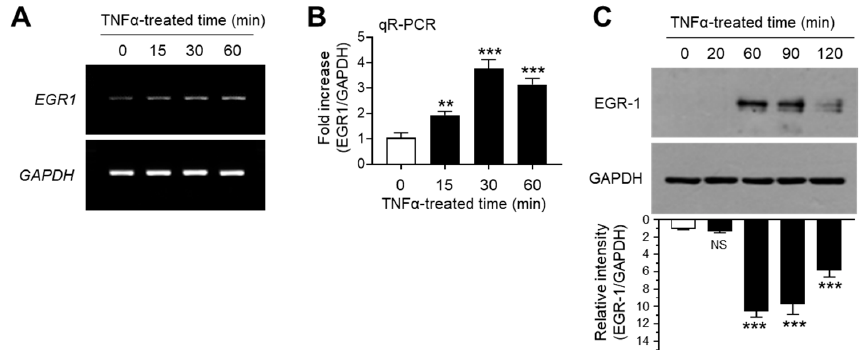
Figure 2. E ff ect of TNF α on early growth response gene 1 (EGR-1) expression. MCF-7 cells were treated with 10 ng / mL TNF α for various durations (0–60 min). ( A , B ) EGR1 mRNA levels were determined by RT-PCR ( A ) and qR-PCR ( B ). GAPDH mRNA levels were used as an internal control. ( C ) EGR-1 levels were measured by immunoblot analysis. GAPDH levels were used as an internal control. Band intensities were measured using the ImageJ software. Bars represent the mean ± SD ( n = 3). ** p < 0.01, *** p < 0.001 by Dunnett’s multiple comparisons test. NS, not significant; qR-PCR, quantitative real-time PCR.